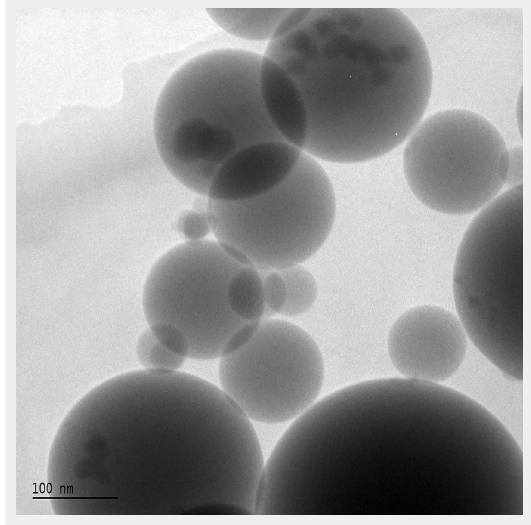
Amorphous “fumed” silica (SiO 2 ) “nano-particles” (ca. 10–200 nm diameter) added to liquid PDMS silicone polymers before they